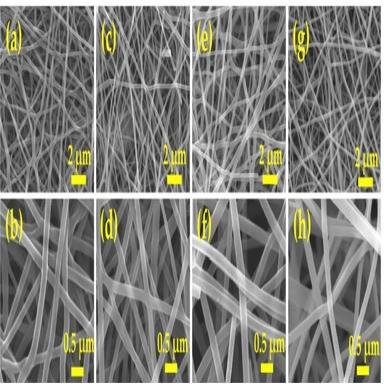
SEM images of CNF (a, b), CNFeZrO2-08 (c, d), CNFeZrO2-18 (e, f), and CNFeZrO2-30 (g, h) samples.